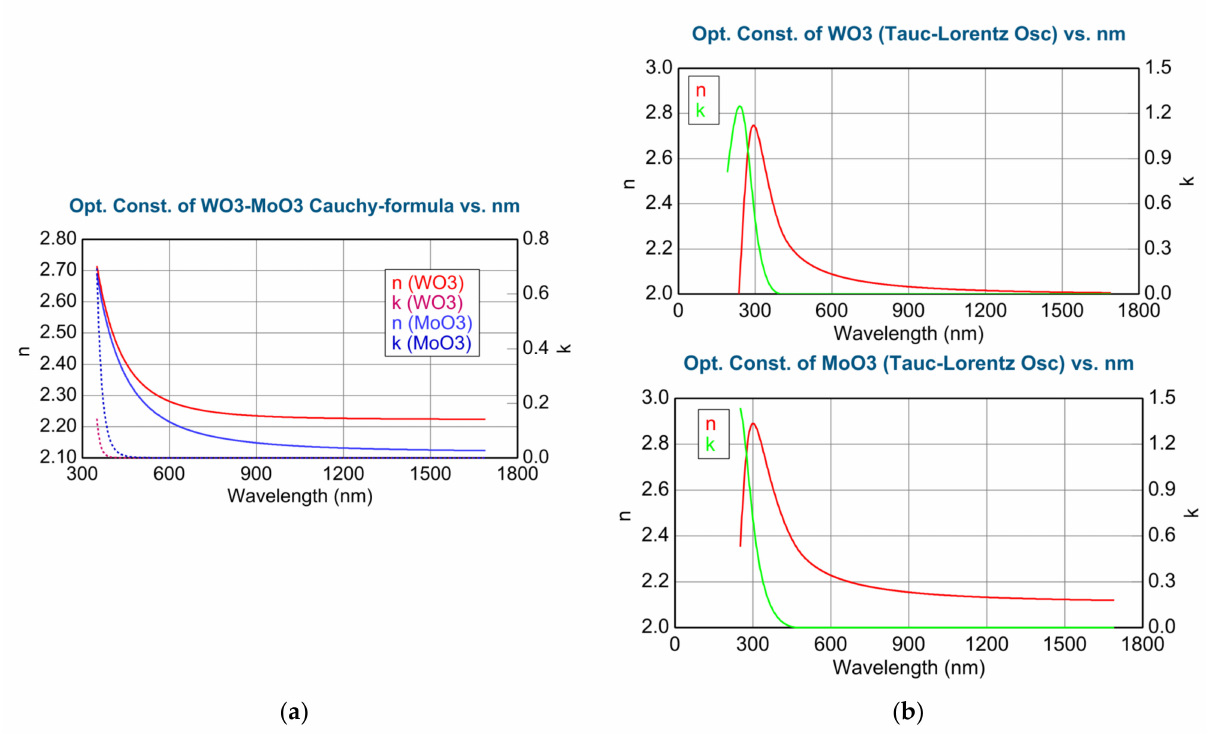
Figure 3. Determined complex refractive indices: ( a ) Using the Cauchy formula for the pure WO 3 and MoO 3 ; ( b ) using the Tauc-Lorentz oscillator model for pure WO 3 (upper) and MoO 3 (lower).